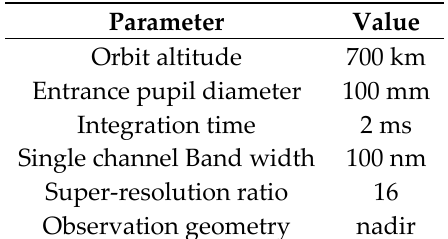
Table 1. Main parameters considered for data